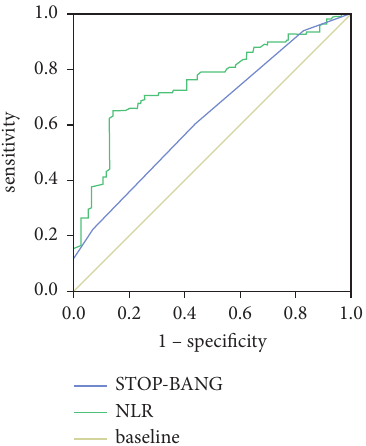
Figure 3: ROC curves of NLR and the STOP-Bang questionnaire for OSA among patients with TBAD (groups A and